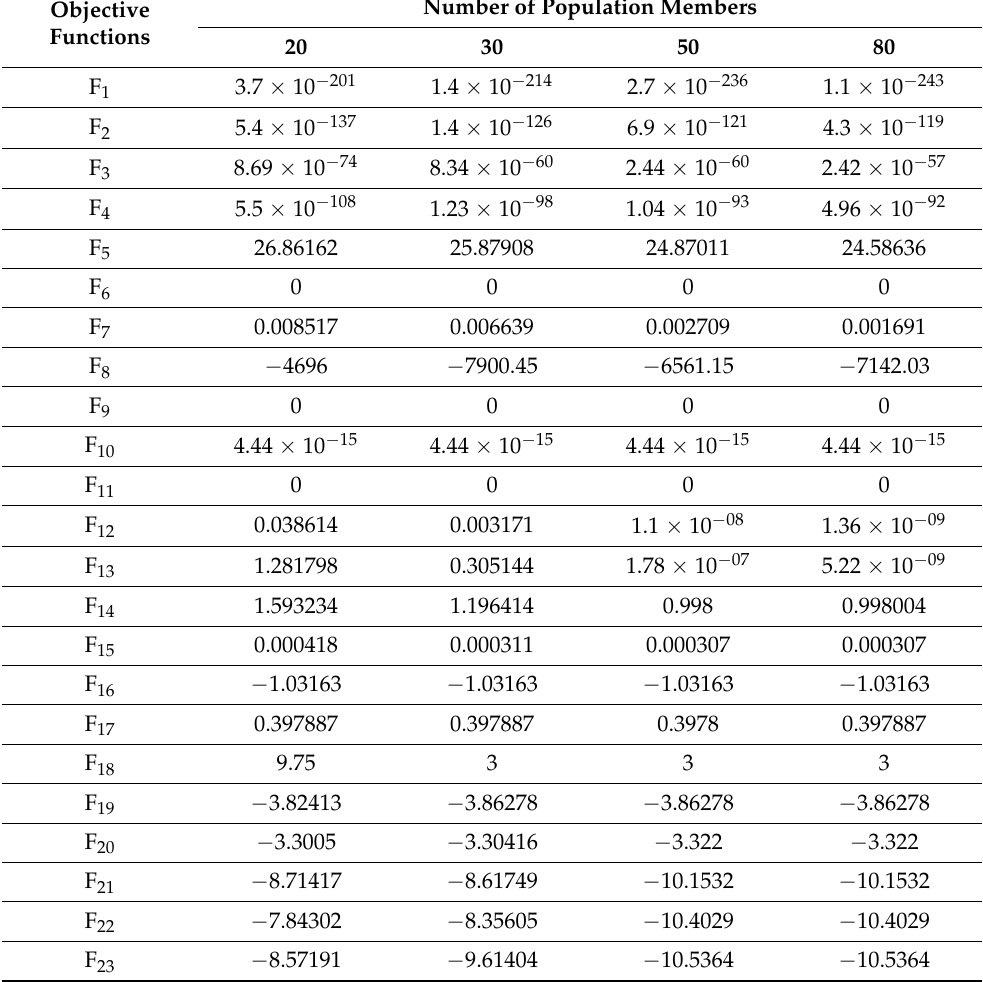
Table 8. Results of the algorithm sensitivity analysis to the number of population